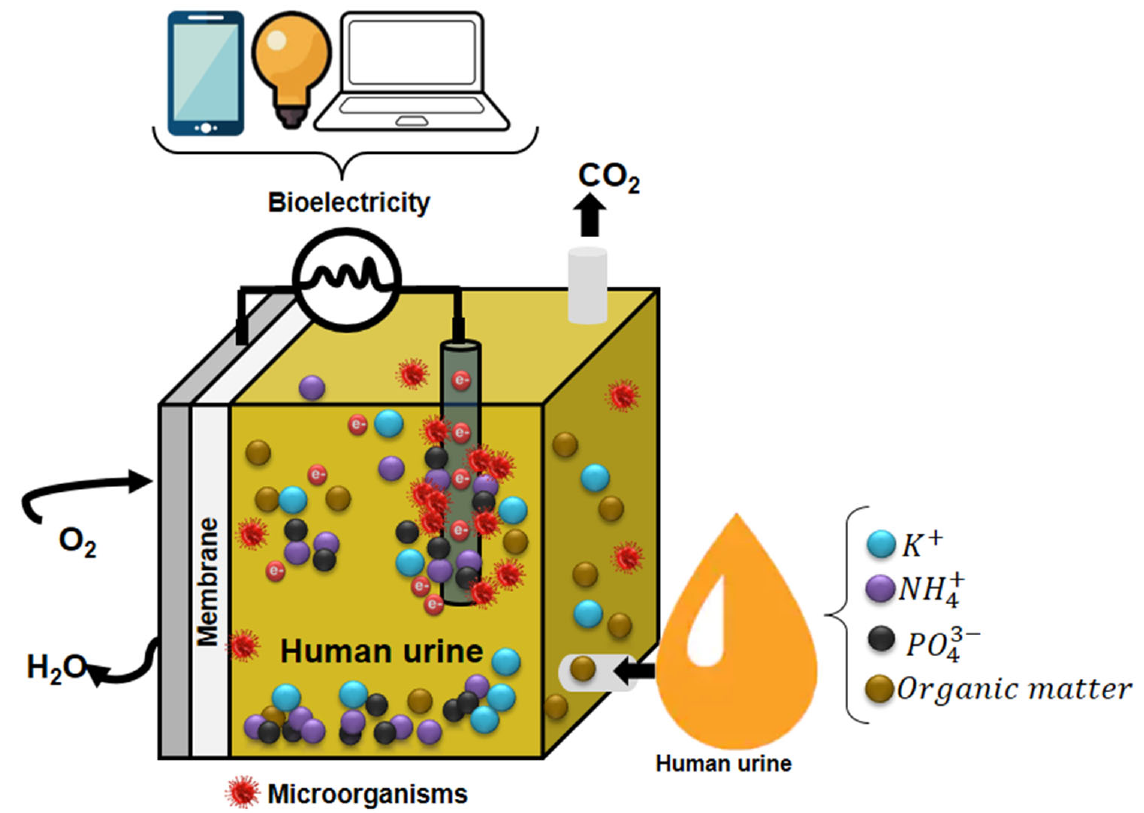
Figure 6. Devices powered by microbial fuel cells are fed with human urine. Table 5. Feeding on urine microbial fuel cells practical applications at laboratory scale. Reactor Device Fed Results Reference